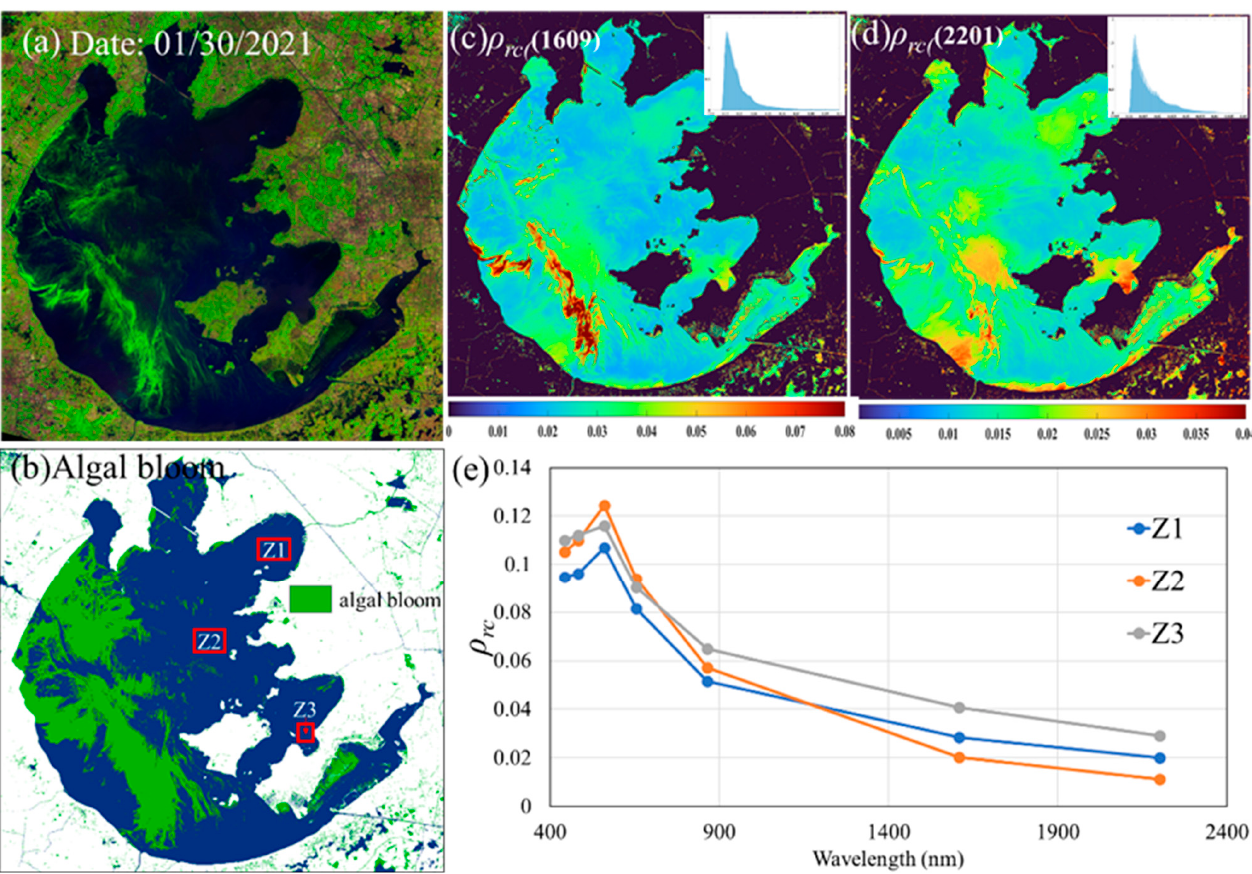
Figure 1. ( a ) False color image (R: SWIR band, G: NIR band, B: Blue band), ( b ) Algal bloom map derived by FAI (floating algae index) [18,19], and the Rayleigh-corrected reflectance ( ρ rc ) in SWIR bands ( c , d ) and its histograms from Lake Taihu with algal bloom on 30 January 2021. ( e ) Average ρ rc from three boxes (Z1, Z2, and Z3) without algal blooms.